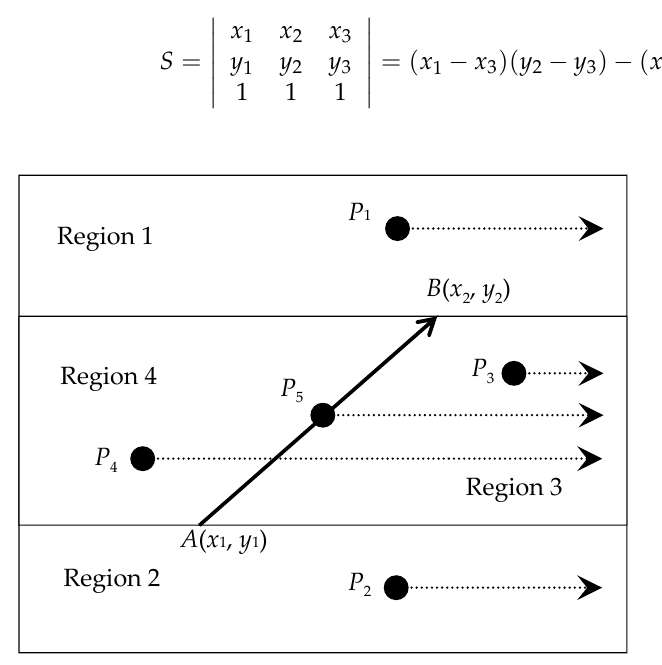
Figure 2. An example of the puncture